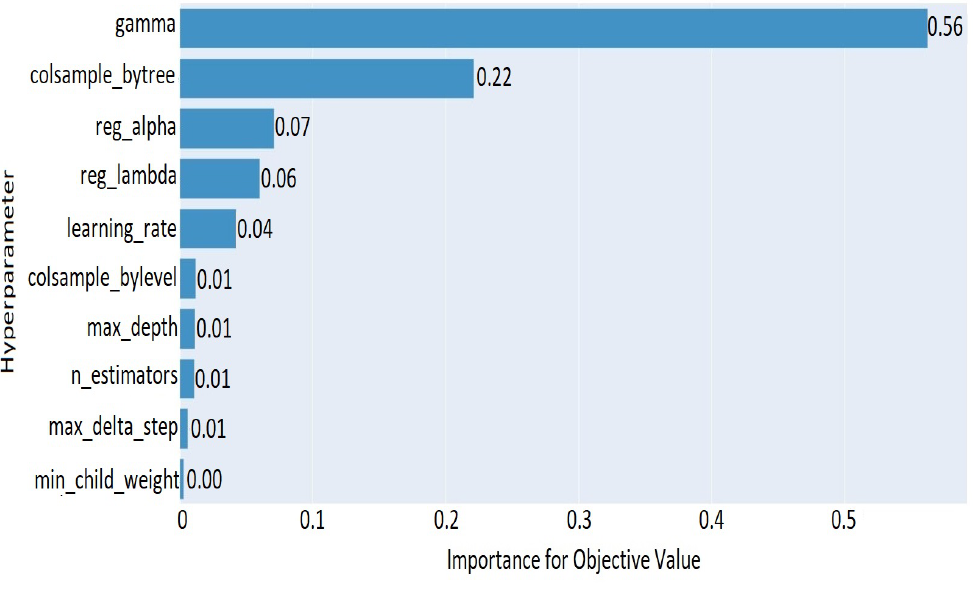
Figure 4. Hyperparameters’ importance for the XGboost classifier.